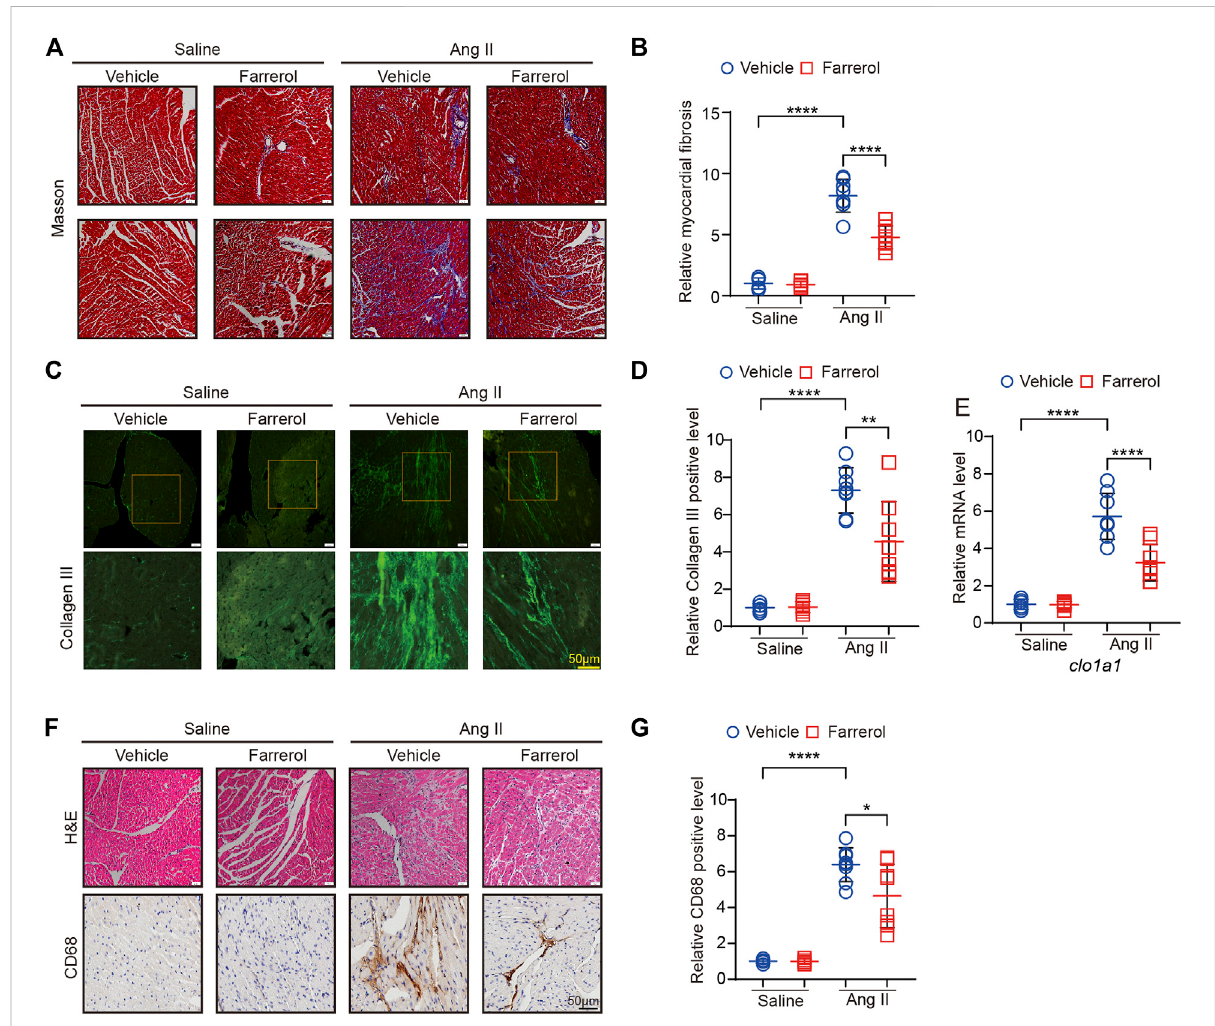
FIGURE 3 FarrerolinhibitsAngII-induced fi brosisandin fl ammationinmice. (A) RepresentativeimagesofheartsstainedwithMasson; (B) Therelativevalue ofcardiac fi brosis ofmiceineachgroup; (C) Representative images ofheartsstainedwith Collagen III; (D) TherelativevalueofCollagen IIIofmicein each group; (E) The mRNA level of cola1 in each group; (F) Representative images of hearts stained with H&E and CD68; (G) The relative value of CD68 of mice in each group (Salline = 6, Farrerol = 6, Ang II = 8, Ang II + Farrerol =